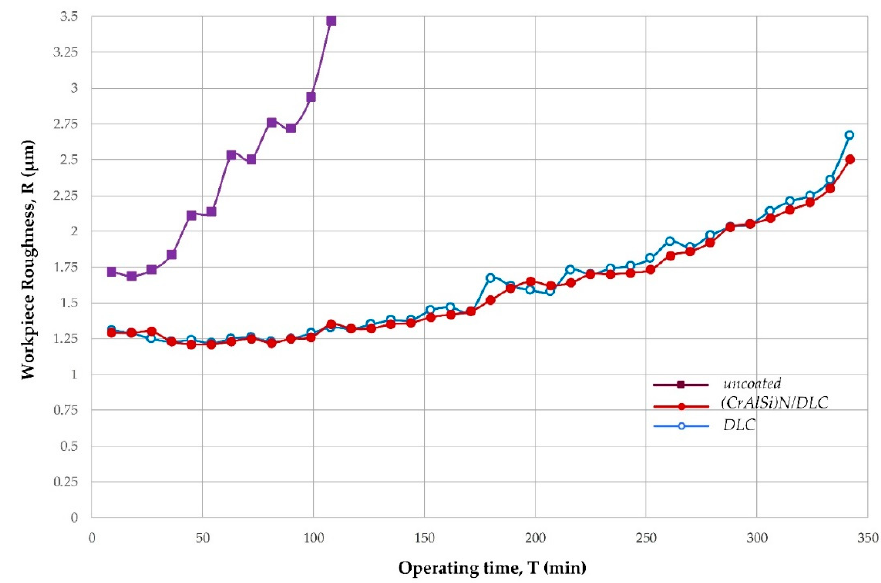
Figure 12. Dependences of the roughness of the treated surface of a workpiece made of aluminum alloy AlCuMg2 on the operating time of end mills with different coatings. alloy AlCuMg2 on the operating time of end mills with di ff erent